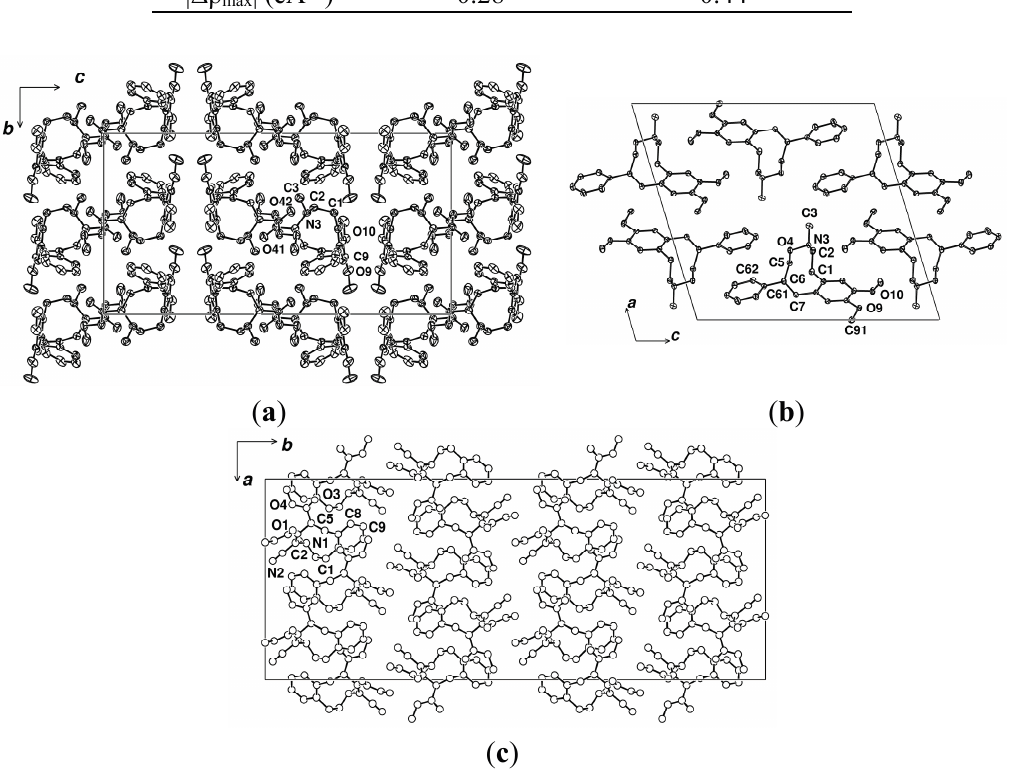
Figure 3. ( a ) Unit cell contents of E - 1 , projected down a , showing the layering normal to c ; ( b ) Unit cell contents of 2 , projected down b ; ( c ) Unit cell contents of AYEKOF [26], projected down c , showing the layering normal to b ( cf.